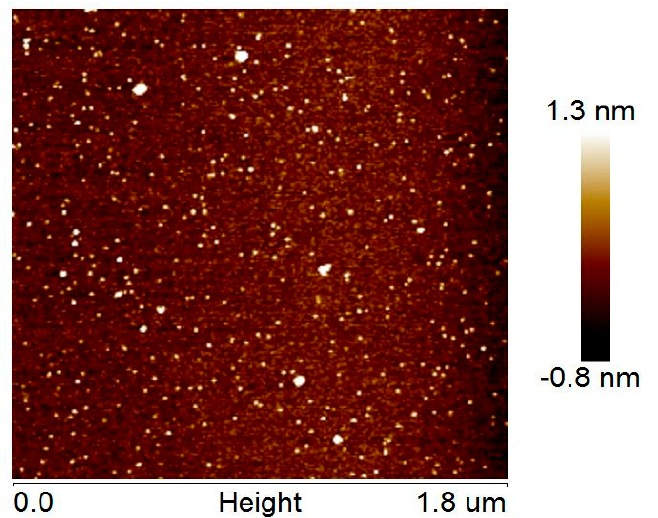
Figure 3. An AFM image of RL2 particles.